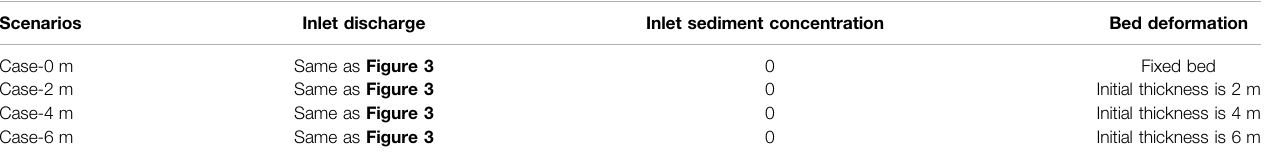
TABLE 1 | Flow conditions for the simulation scenarios. Scenarios